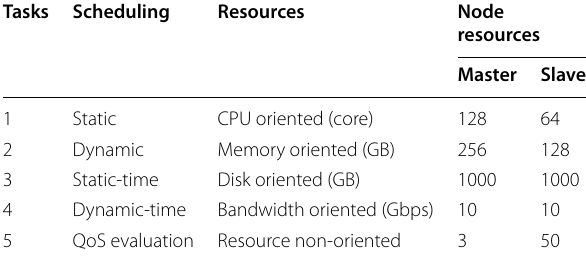
Table 2 Dataset descriptions